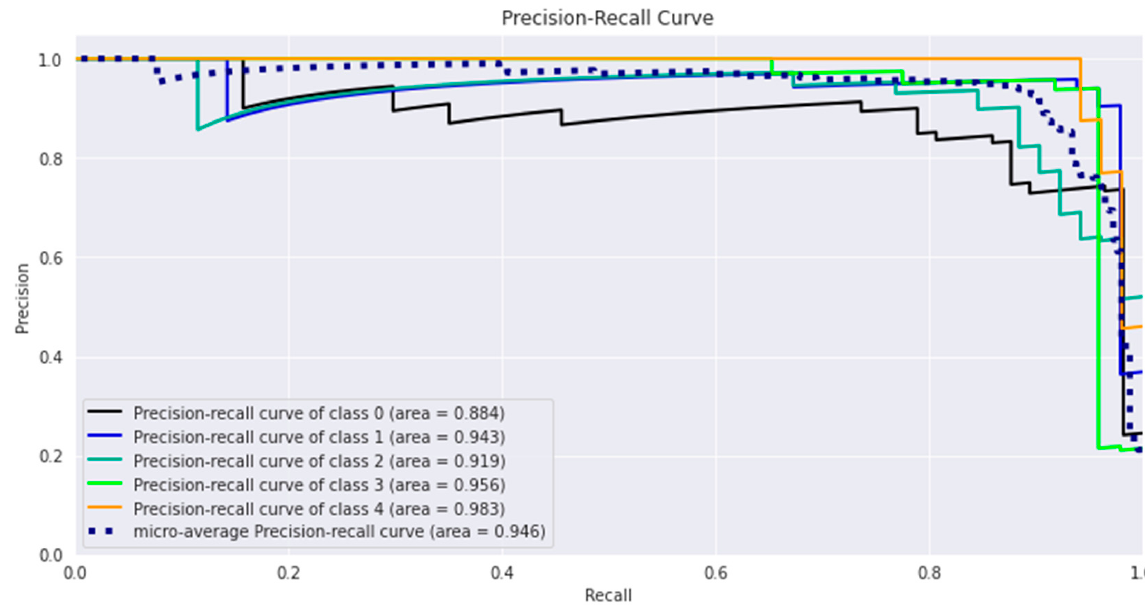
Figure 15. Precision-recall curve of 3 × 3 configuration.